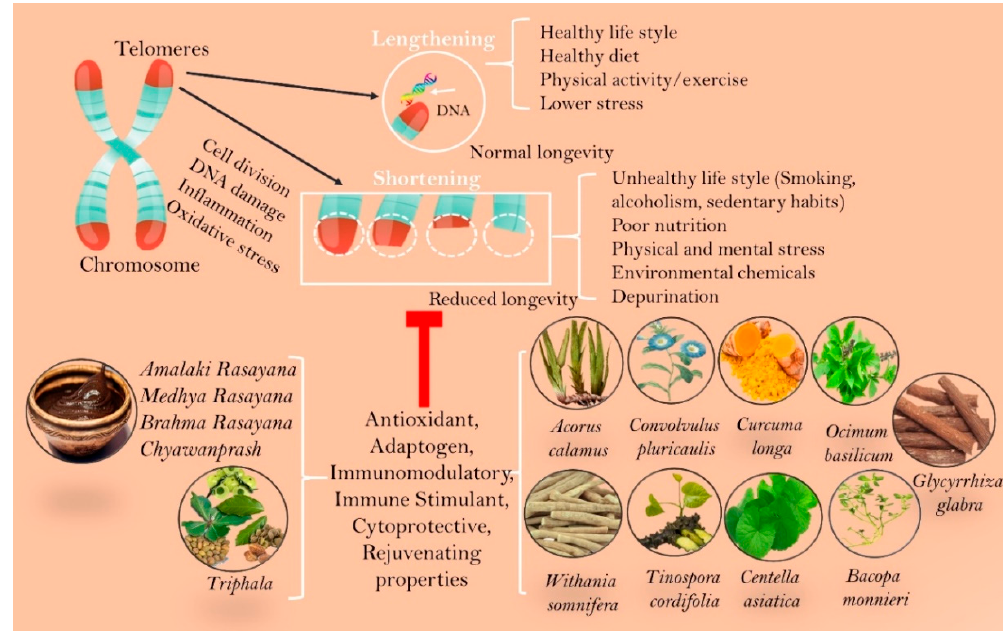
Figure 1. Potential anti-ageing Ayurveda medicines with telomer protective and DNA repair